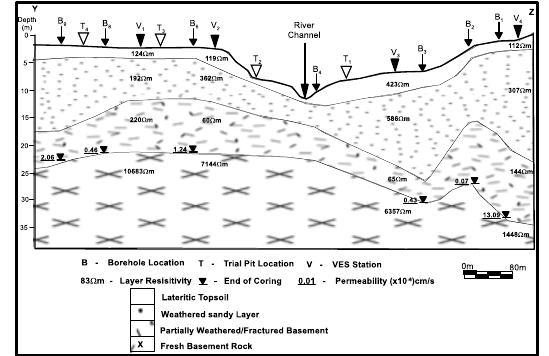
Figure 5: Geoelectric Section along Dam Axis A